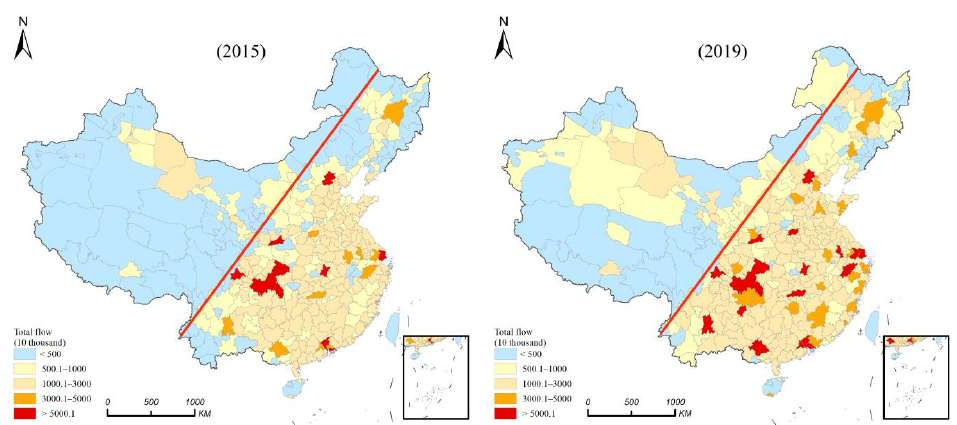
Figure 2. The total population flow in the early Spring Festival travel season. From the perspective of the evolutionary characteristics of the total population flow, the total scale of population flow during the Spring Festival travel season in China from 2015 to 2019 showed an increasing trend. The first and third levels expanded considerably between the levels, and a T shape formed between the Hu Huanyong Line and the Lanxin Line. The source area is at the forefront of the growth in the population flow space. There is also strong spatial heterogeneity in the increase in population flow. In 2015, the first level of population flow in the north, Shanghai, Guangzhou, and Shenzhen, as well as the central and western regions of Wuhan, Xi’an, Chongqing, and Chengdu, reached 68.779 million, accounting for the approximate population of the entire country. Of the popula- tion flow, 16% has undoubtedly become a national population flow distribution center, playing an important role in the population flow pattern. The second tier is dominated by provincial capitals such as Hangzhou, Nanjing, and Hefei. The population flow has a strong degree of activity and most urban population flows are distributed in a spatially staggered manner between the third and fourth levels. The fifth-tier cities are mainly con- centrated in western Huxian or along its border cities, with a small population base and a small total population flow (Figure 2). In 2019, the total population flow pattern was dom- inated by large cities, showing a trend of fragmentation. The population flow in urban agglomeration areas is relatively active (Figure 2). The number of first-tier cities has dou- bled, and the newly added cities are mainly provincial capitals and cities. The first and second levels of the core cities in the urban agglomeration initially outlined the major ur- ban agglomerations in China. Urban agglomerations and provincial capitals such as the Pearl River Delta, Yangtze River Delta, Beijing-Tianjin-Hebei region, Chengdu-Chong- qing area, and middle reaches of the Yangtze River are important carriers of population mobility and dominate the population movement in China. However, important labour export cities such as Ganzhou, Hengyang, and Zunyi also emerged in the second level.